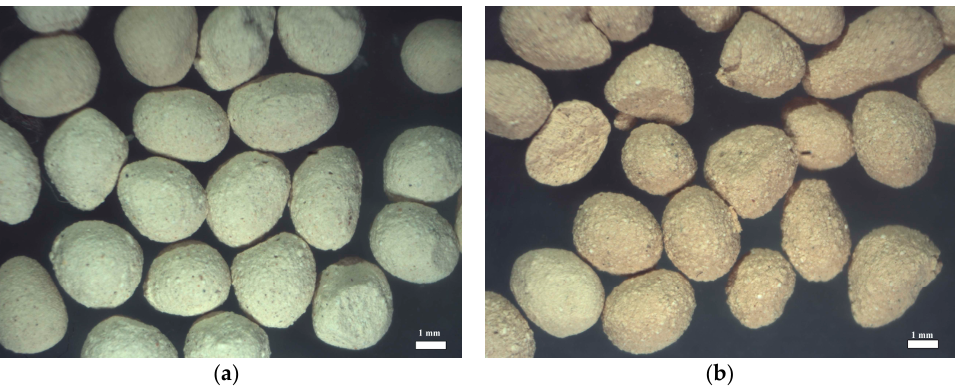
Figure 2. Microscopic images of the natural zeolite-alginate beads (NZA) ( a ) and Fe(III)-modified zeolite bead (FeA) ( b ). zeolite bead (FeA) ( b